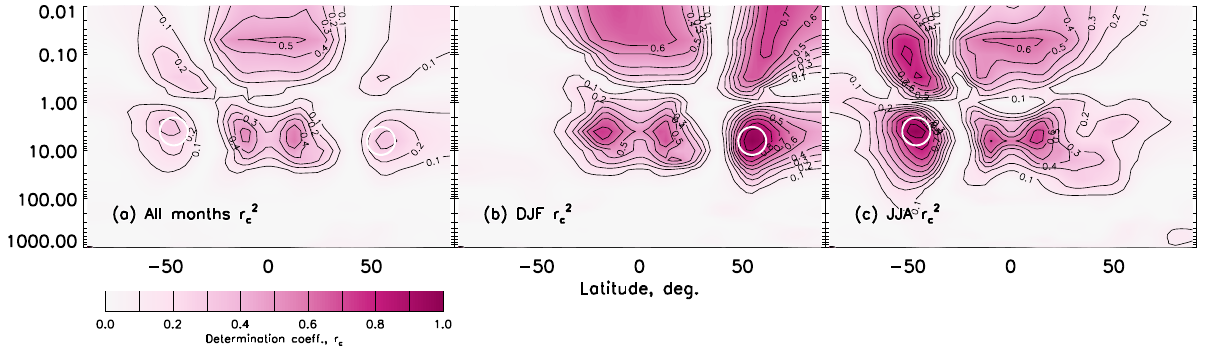
Figure 9. Coefficient of determination ( R 2 ) maps of the upper-branch Brewer–Dobson circulation (UBDC) index with SOCOL model temperature at all latitudes and altitudes for (a) all months, (b) DJF, and (c) JJA. White circles represent the approximate region that the UBDC index is derived from.